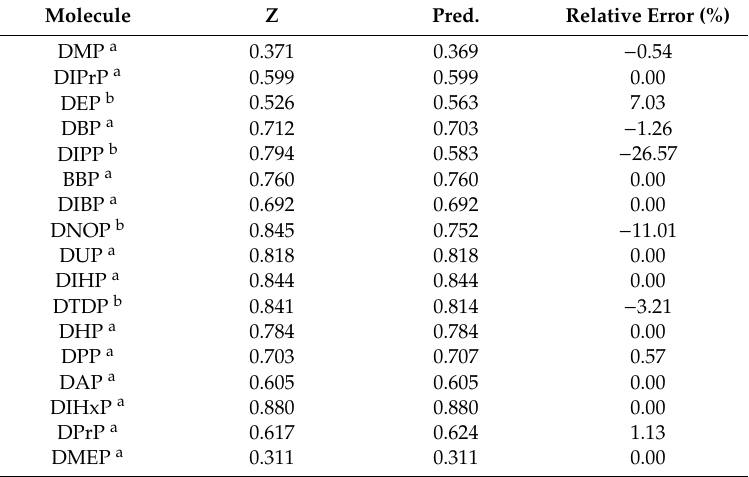
Table 2. Comprehensive evaluation value Z of PAEs’ flammability, biotoxicity, and enrichment multi-e ff ect, predicted values (Pred.) and relative errors.